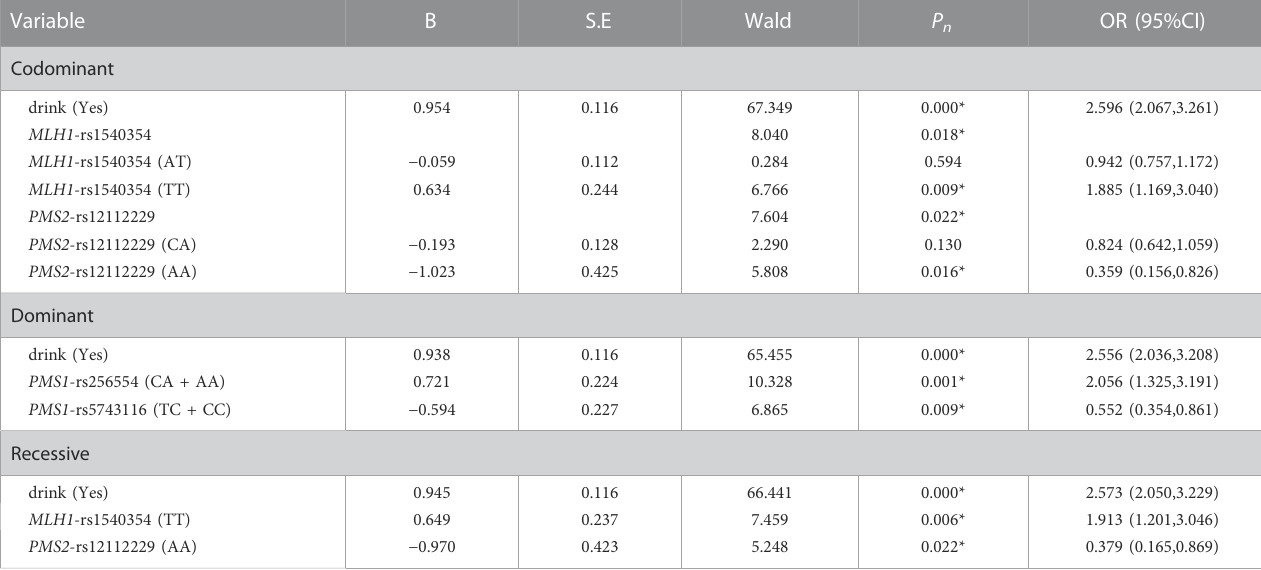
TABLE 6 The multivariate Logistic Regression analysis of predictive factors for the ability of HBV spontaneous clearance under three models in SC vs. HLD group. Variable